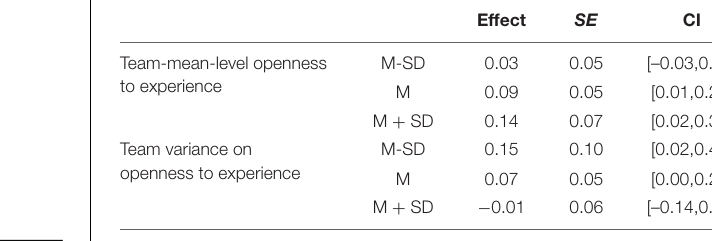
TABLE 3 | Test of the mediated moderating